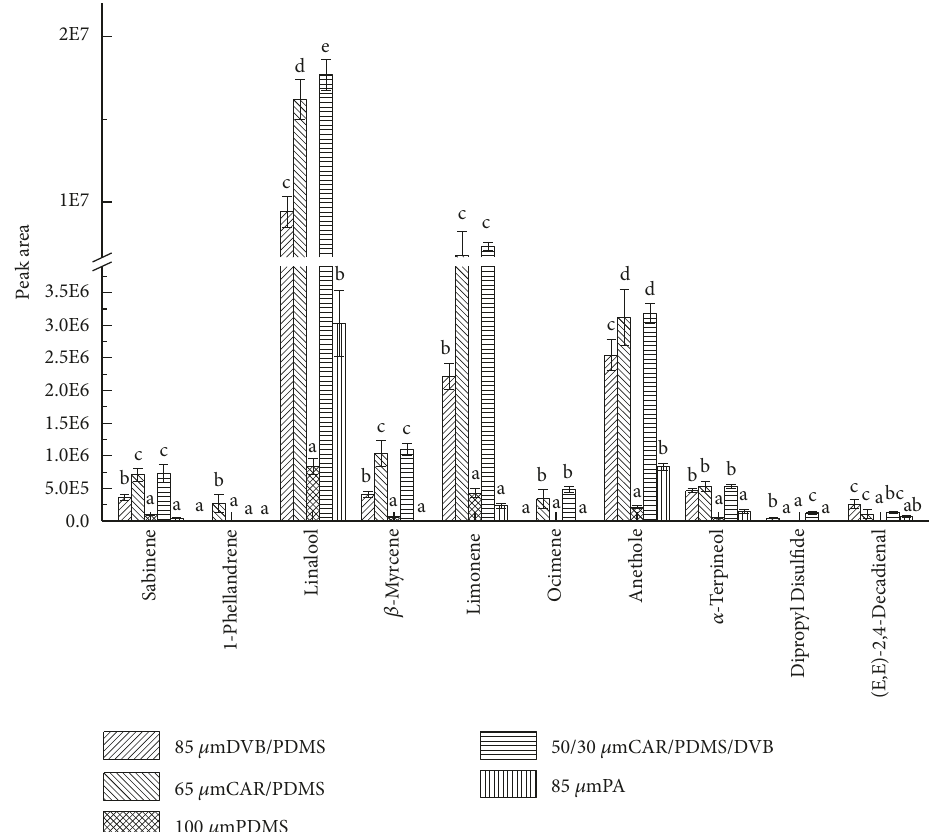
Figure 3: Effects of the five fibers on peak areas of the ten key aroma compounds. English letters “a”, “b”, “c”, “d”, “e” indicate Duncan’s multiple range test among peak areas of the five fibers. Data in the same compound marked with different letters mean significant difference ( p < 0.05) and the same letters denote not significant difference (p <